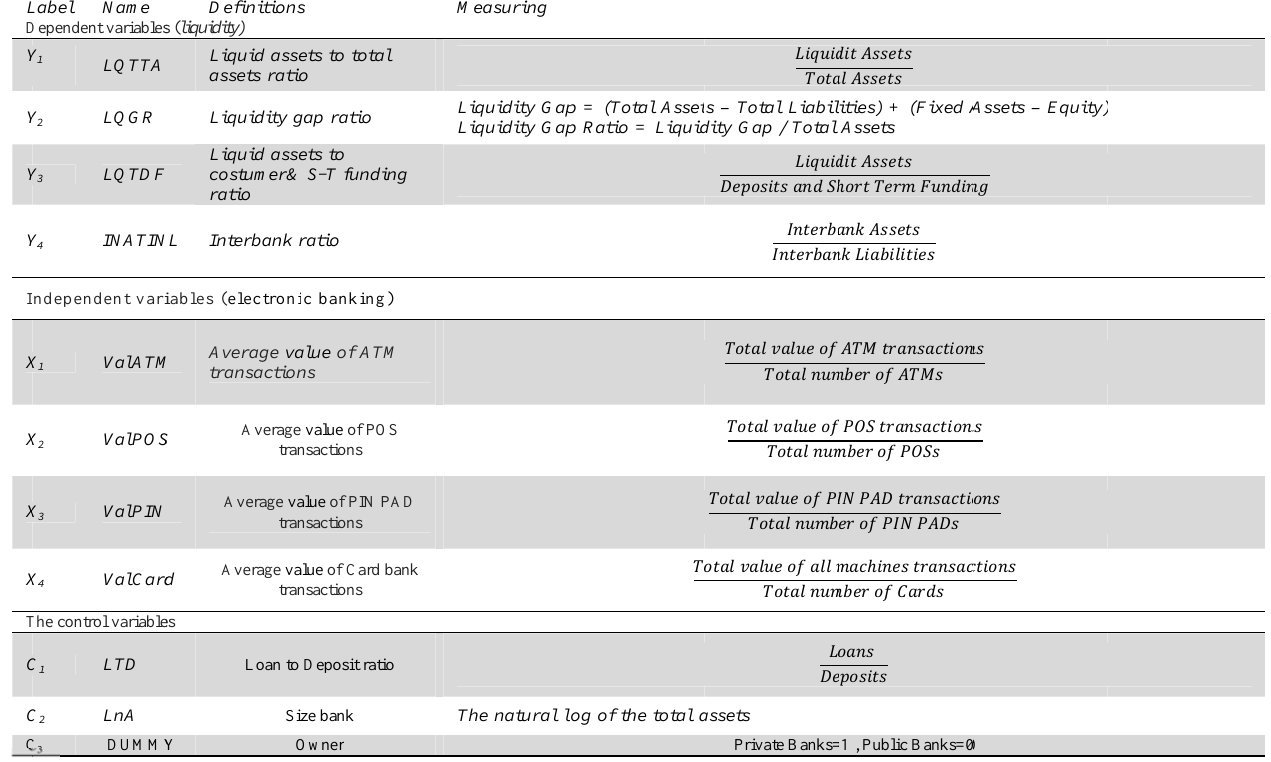
Variables an Name Label Dependent variables